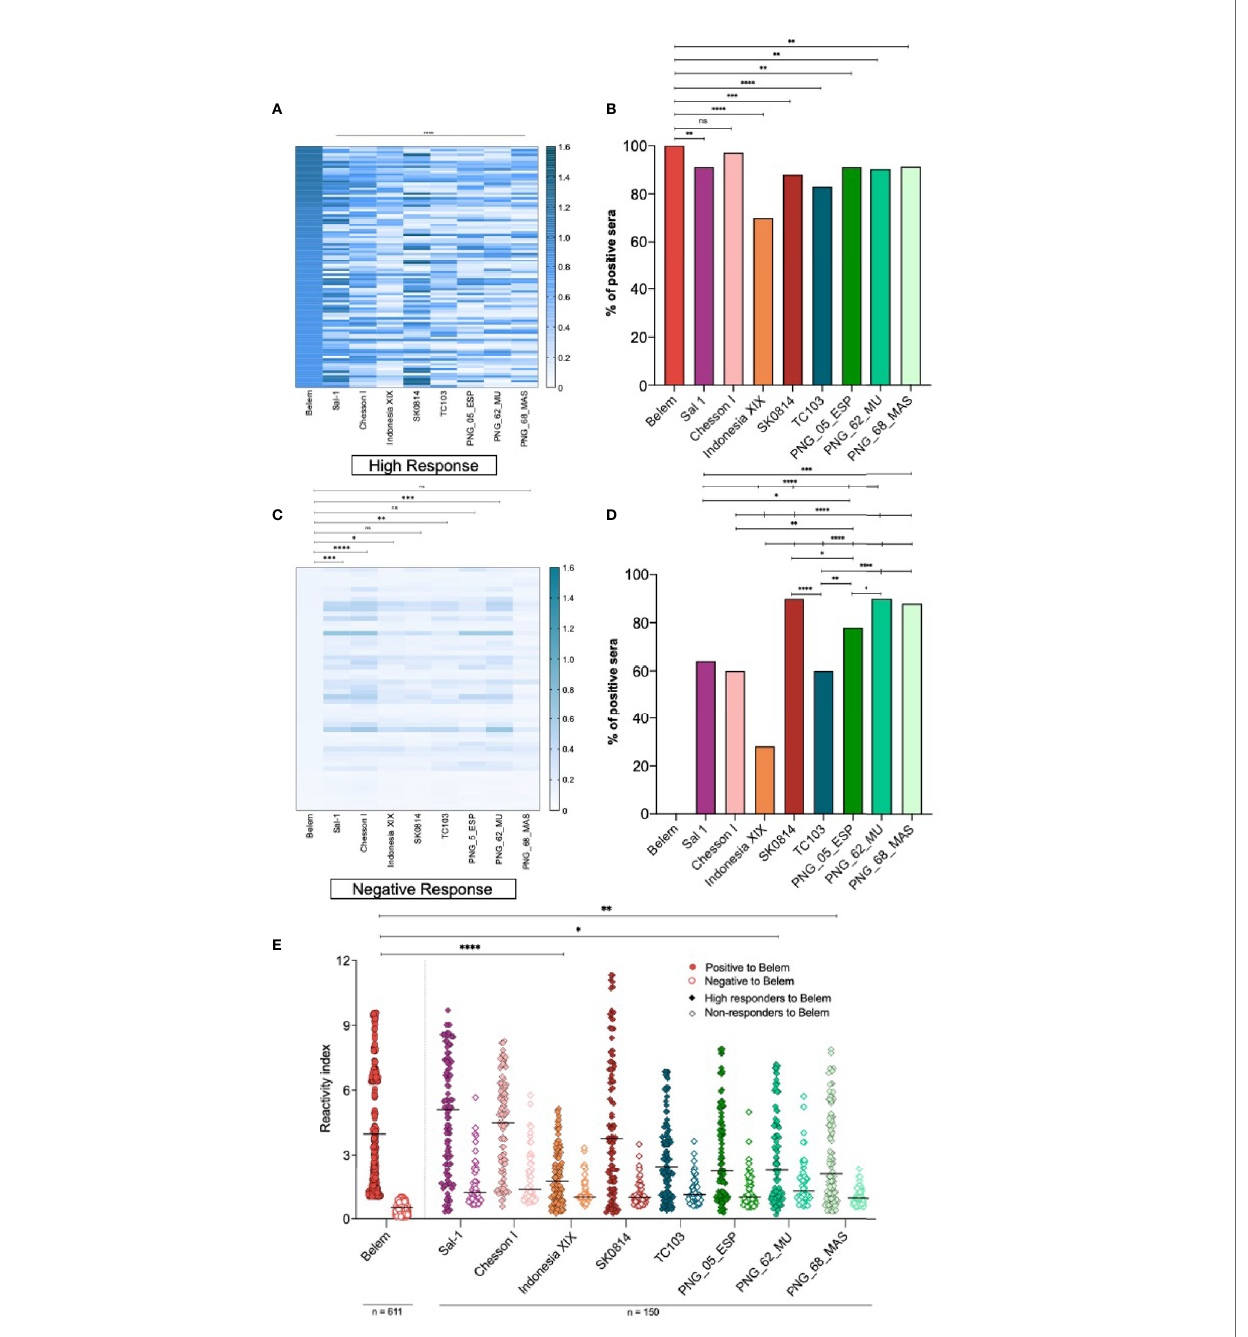
FIGURE 4 | Comparison of the IgG antibody response against different PvAMA-1 variants in individuals exposed to malaria. (A) Heatmap of the anti-PvAMA-1 IgG magnitude derived from serum samples of 100 positive individuals for recognizing the PvAMA-1 Belem protein. These patients presented OD 492 values >0.8 to PvAMA-1 Belem and were tested for the other variants: Sal 1, Chesson I, Indonesia XIX, SK0814, TC103, PNG_05_ESP, PNG_62_MU and PNG_68_MAS. Each line represents one sample, while the columns are representative of each protein variant. The closer the OD 492 value is to 1.5, the darker the nuance in the graph. **** p < 0.0001. (B) Response against the variants studied in 100 individuals previously tested for the Belem strain. ns p > 0.05, ** p < 0.01, *** p < 0.001, **** p < 0.0001, Fisher´s test. (C) Heatmap of the IgG magnitude in samples from 50 serologically negative individuals for the PvAMA-1 Belem protein compared to other variants. Fifty patients with an OD 492 value equal to or lower than the cutoff value (0.125) were tested for the other variants as described on item (A) ns, non signi fi cant, p>0.05, * p < 0.05, ** p < 0.005, *** p < 0.001, **** p < 0.0001, Kruskal-Wallis. (D) Response against the variants studied in 50 individuals negative to the Belem strain. * p < 0.05, ** p < 0.01, *** p < 0.001, **** p < 0.0001, Fisher´s test. (E) Reactivity index against the PvAMA-1 Belem protein (611 individuals) or against other variants (150 individuals: 100 positive to Belem strain and 50 negative to Belem strain). The horizontal black lines over the symbols indicate the median with a 95% con fi dence interval. * p < 0.05, ** p < 0.005, **** p < 0.0001, Kruskal-Wallis